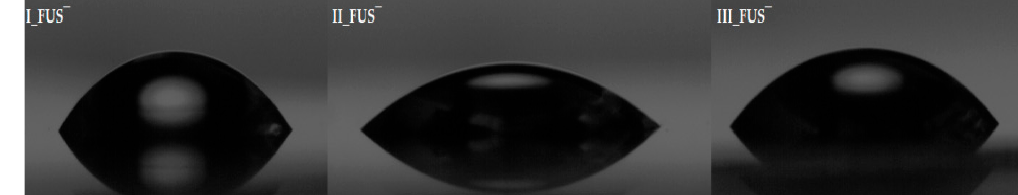
Figure 3. Screen shots during sessile water drop measurements for FUS